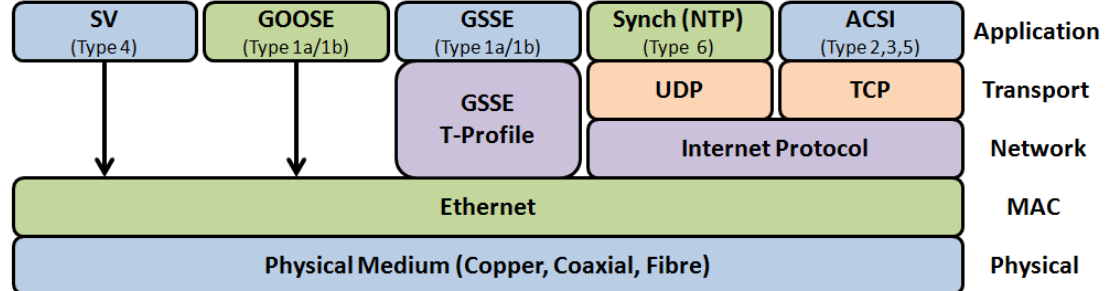
Figure 3. Typical IEC 61850 Ethernet-based communication stack.